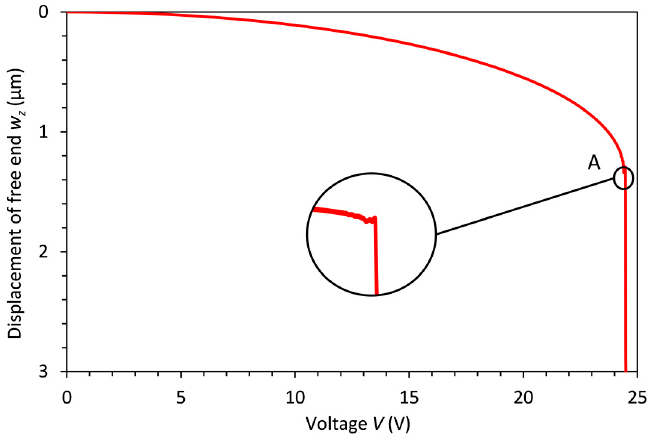
Figure 7. Displacement of the free end (tip) of an Al cantilever as a function of voltage.